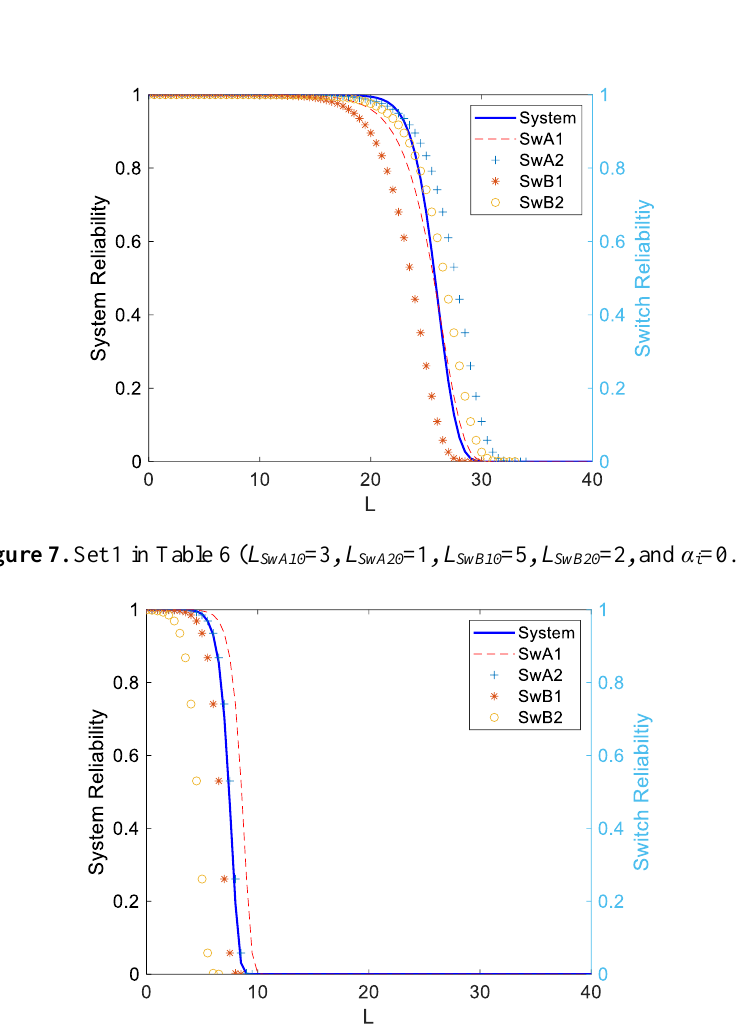
Figure 8. Set 2 in Table 6 ( L SwA10 = 1, L SwA20 = 2 , L SwB10 = 3, L SwB20 = 5, and α i = 1.5).